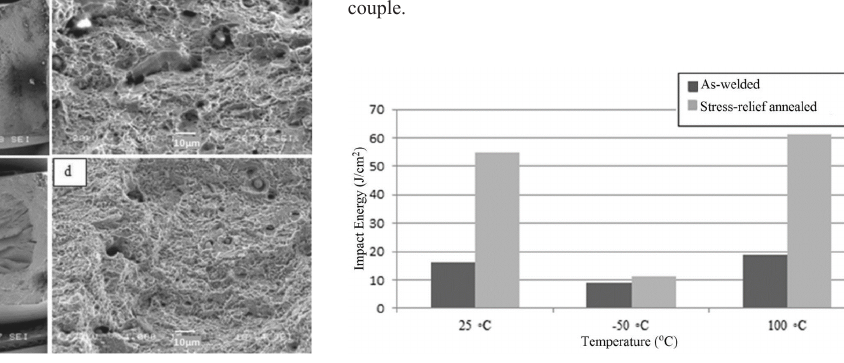
Figure 8. The charpy impact properties of as-welded and stress relief annealed